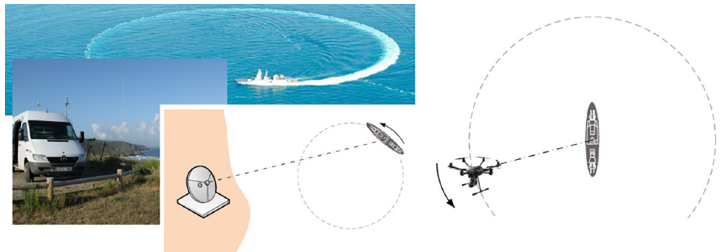
Fig 1. Antenna’s radiation pattern obtention methods: Conventional (left, the ship circles and a probe antenna stays in the coast) and alternative (right, the vessel is static at sea and a UAV circles it).